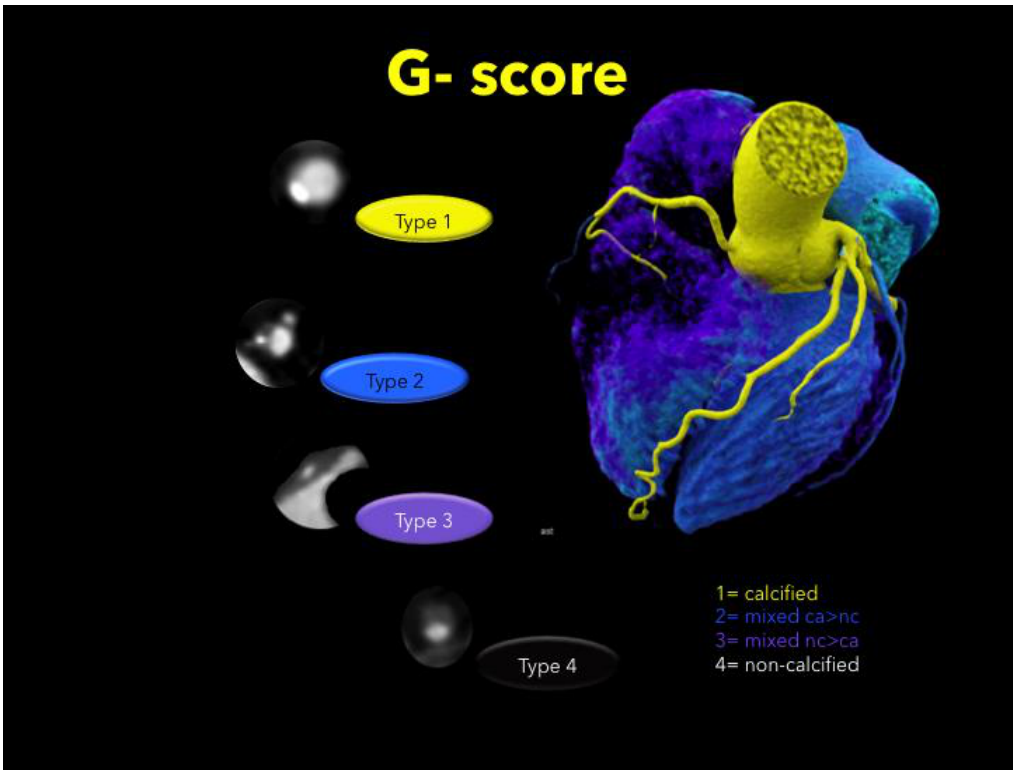
Figure 1. Total plaque burden weighted for non-calcified plaque (G-score). The sum of plaque type 1 – 4 was calculated for each AHA segment (16-segment classification).